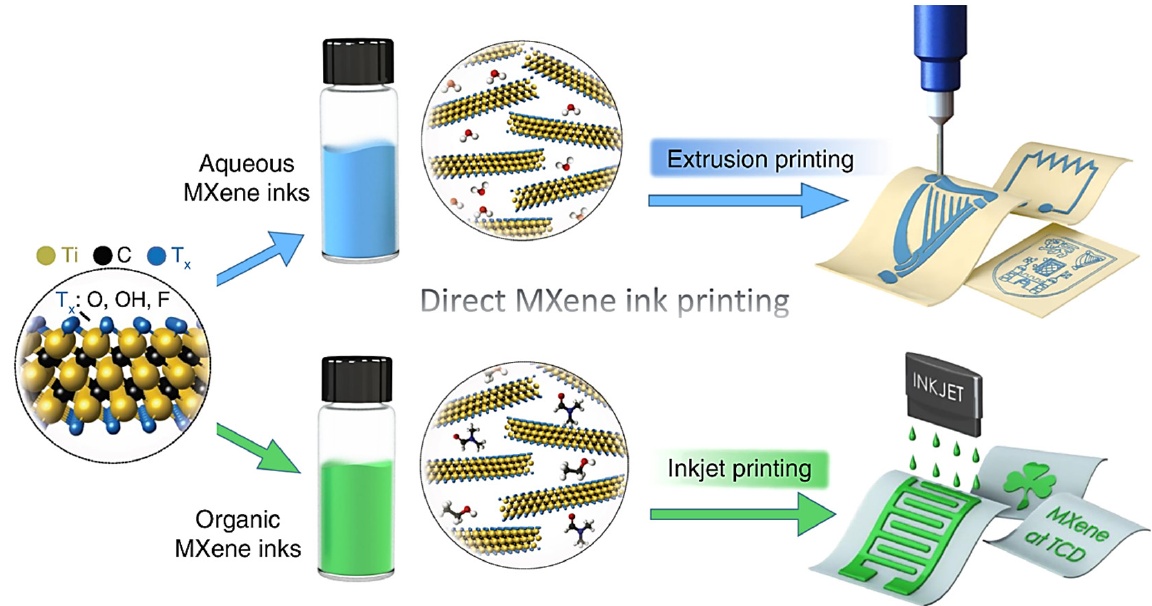
Figure 6. Schematic description of MXene ink printing. ( Top ) The Ti 3 C 2 T x aqueous ink (Ti 3 C 2 T x dispersed in water) is appropriate for extrusion printing. ( Bottom ) The Ti 3 C 2 T x organic ink (Ti 3 C 2 T x dispersed in ethanol) is suitable for inkjet printing. [31]. Copyright 2019, Springer Nature.